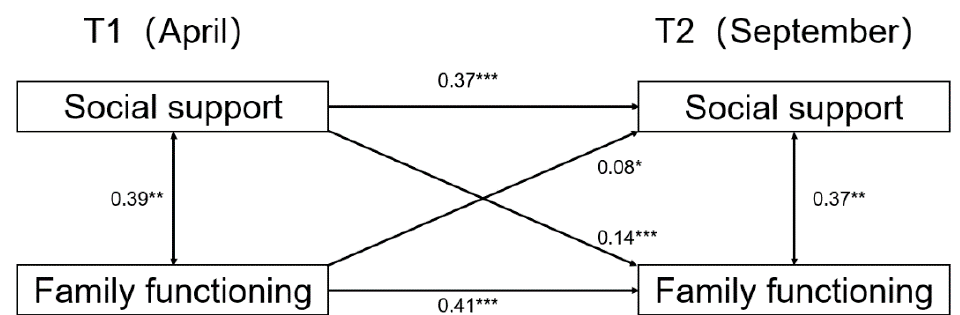
Figure 1. Cross-lagged model for social support and family functioning for the total sample. Note: statistically significant standardized path coefficients are shown with solid lines. * p < 0.05. ** p < 0.01. *** p < 0.001.